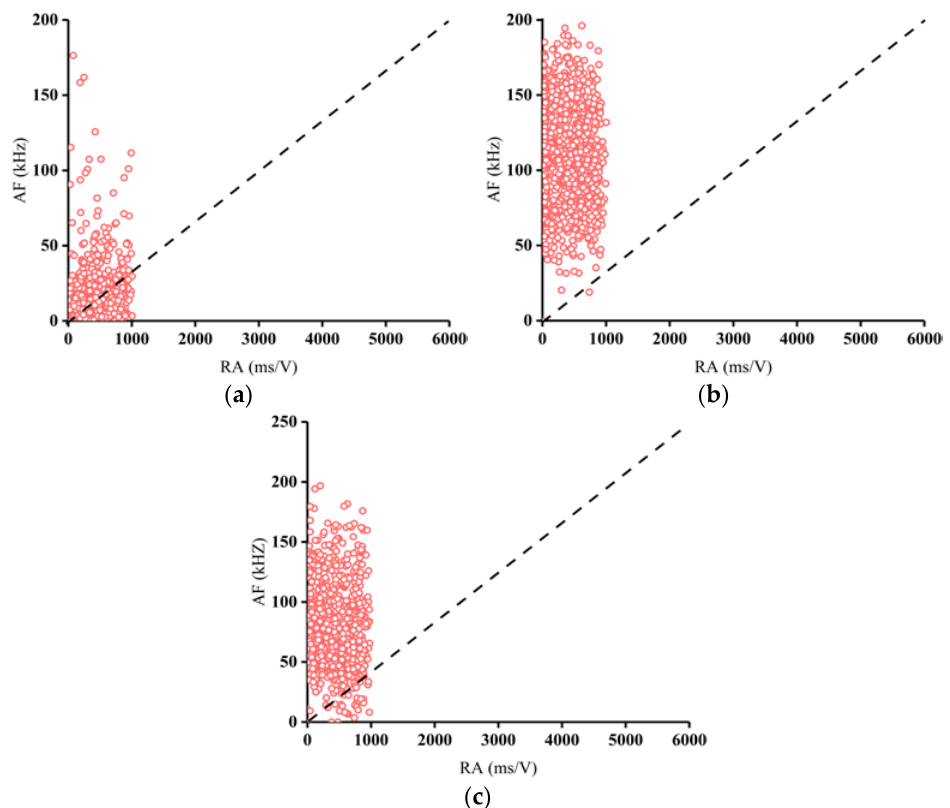
Figure 10. Analysis of the fracture mechanism at the interface of mortar rubble. ( a ) SRB-1. ( b ) SRG- 1. ( c ) SRL-1. ( c )